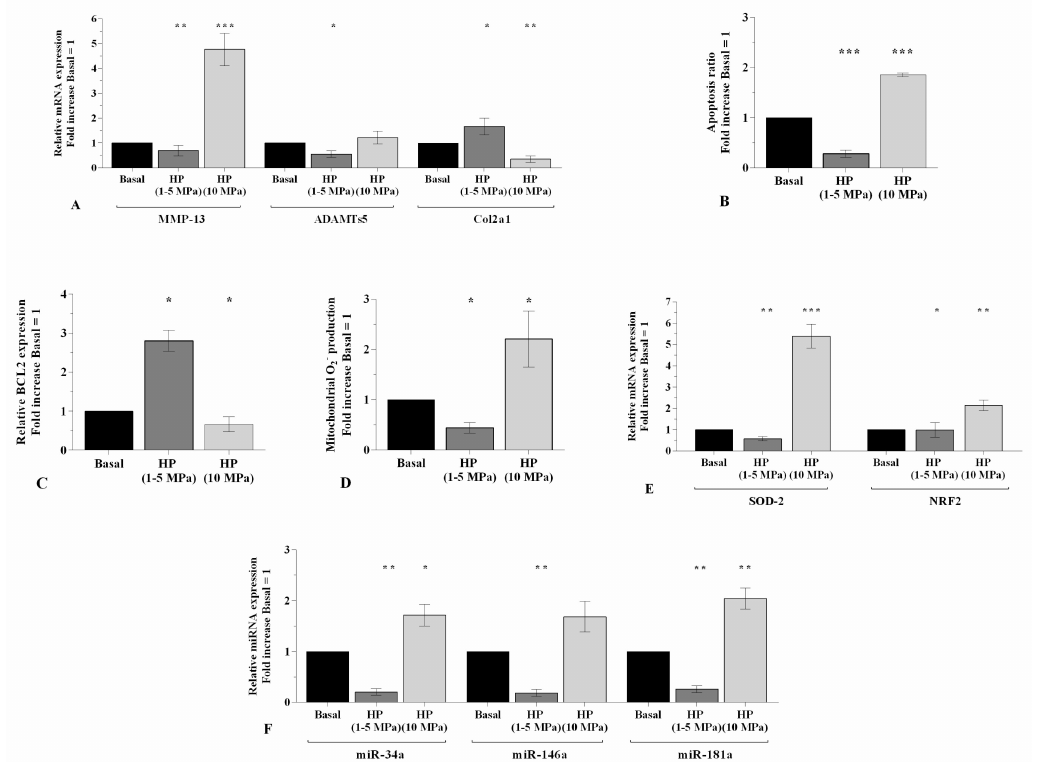
Figure 1. E ff ects of HP exposure on chondrocyte metabolism. ( A , C , E , F ) Expression levels of MMP-13 , ADAMTS-5 , Col2a1 , BCL2 , SOD-2 , NRF2 , miR-34a , miR-146a , miR-181a analyzed by quantitative